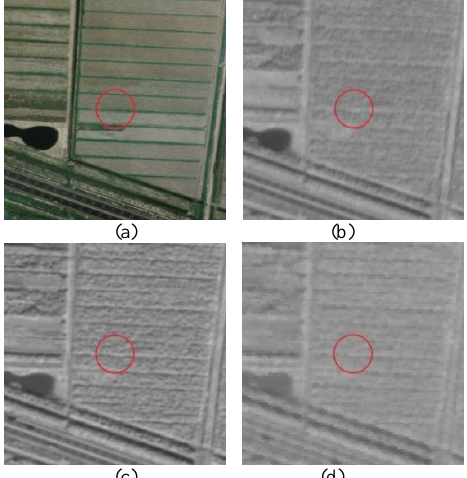
Figure 1. Registration between the GLAS footprint and ZY-3 stereo-images: (a) referenced DOM; (b) ZY-3 forward image; (c) ZY-3 nadir image; (d) ZY-3 backward image;. In (a) to (d) the circle represents the position of the GLAS footprint, and image matching is restricted to within the circle to obtain the vertical GCPs and the corresponding image points.